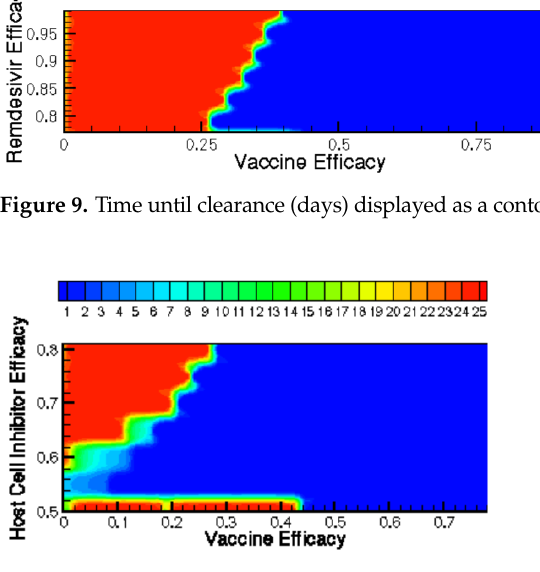
Figure 10. Time until clearance (days) displayed as a contour function of vaccine and host-cell entry inhibitor efficacy.